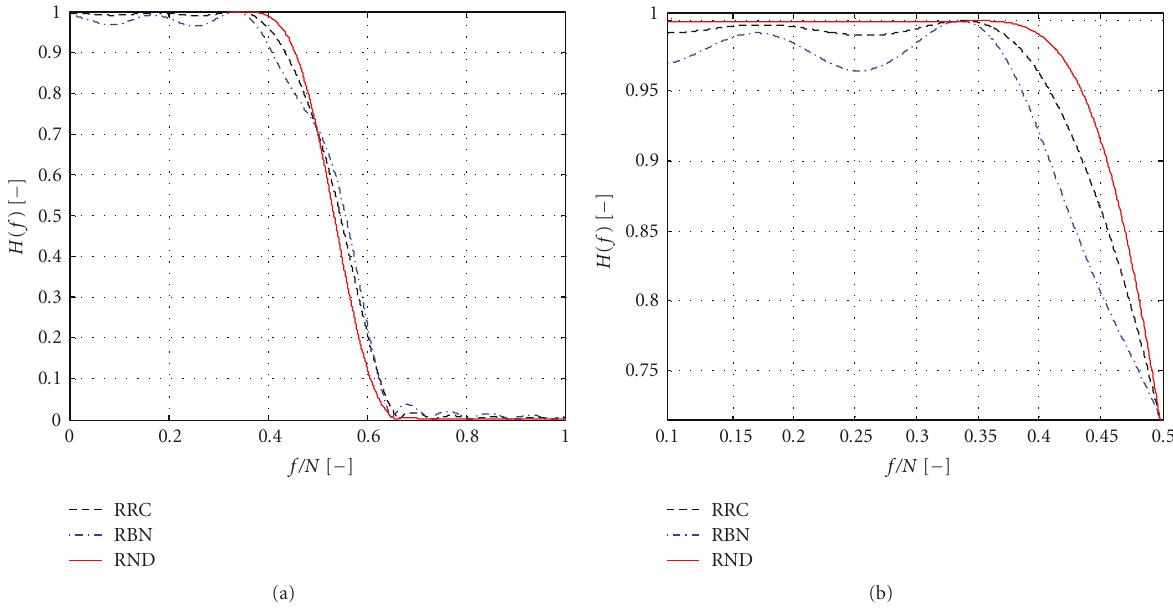
Figure 7: Amplitude frequency characteristics (linear scale) of the truncated square root RC filter (RRC); square root B -filter (RBN); square